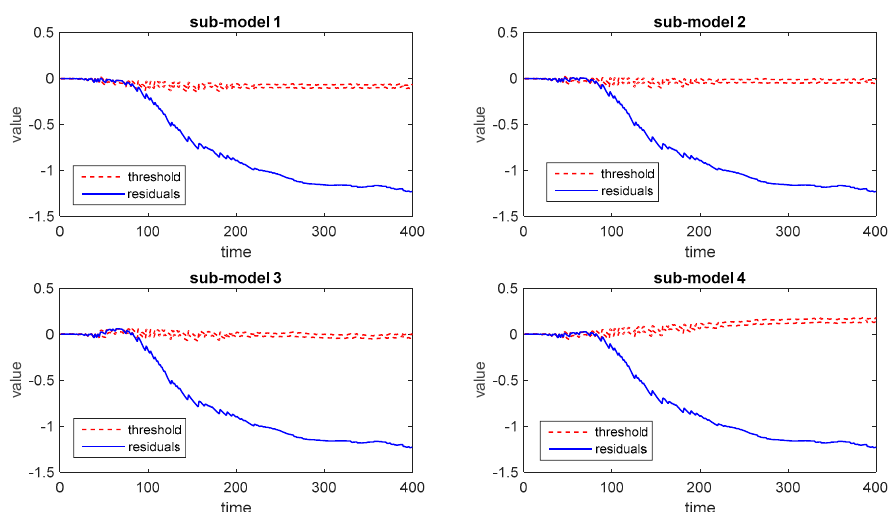
Figure 11. Monitoring results of fault 2 in penicillin fermentation case.